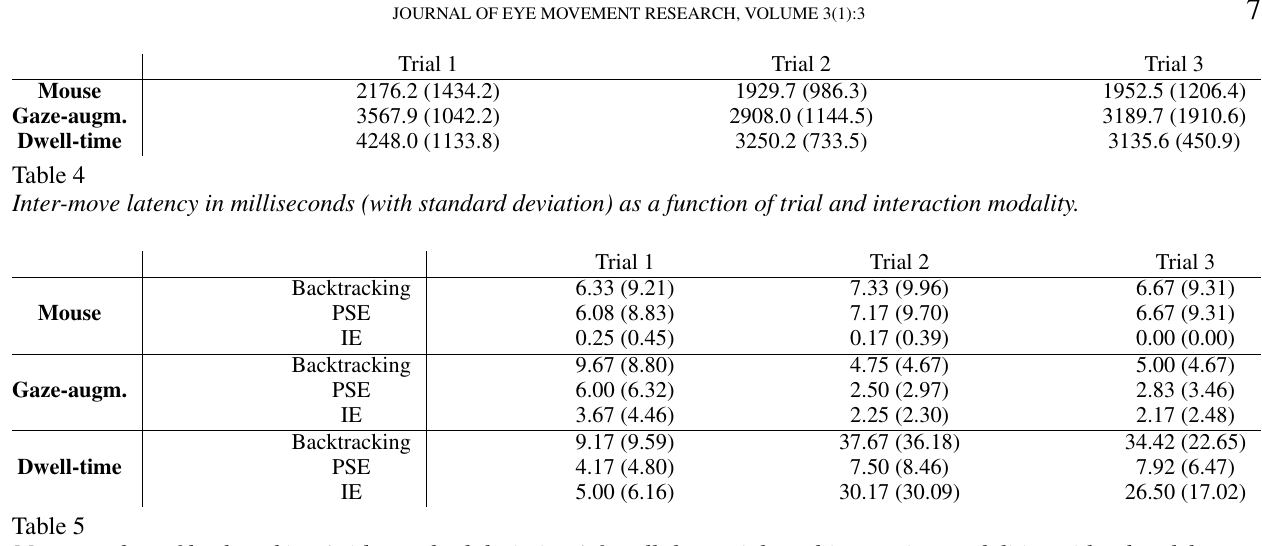
Mean number of backtracking (with standard deviations) for all three trials and interaction modalities with a breakdown to backtracks due to Problem-solving Errors (PSE), and Interaction Errors (IE).